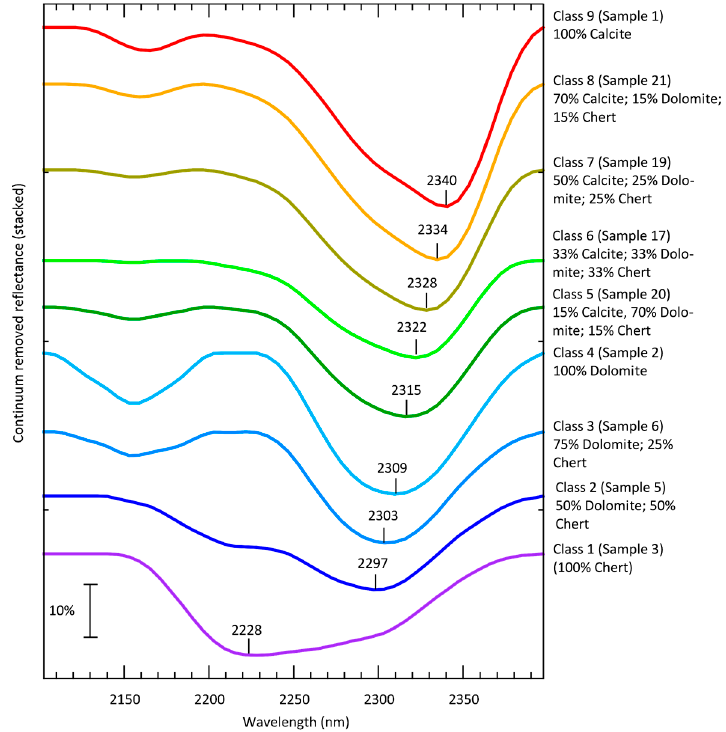
Figure 6. ( A ) Comparison of mineral abundances from point count in comparison to pixels counted from HSI-derived mineral maps using absorption minimum location, and ( B ) graphs that compare the abundances of each mineral with HSI on the y -axis and point counting on the x -axis.